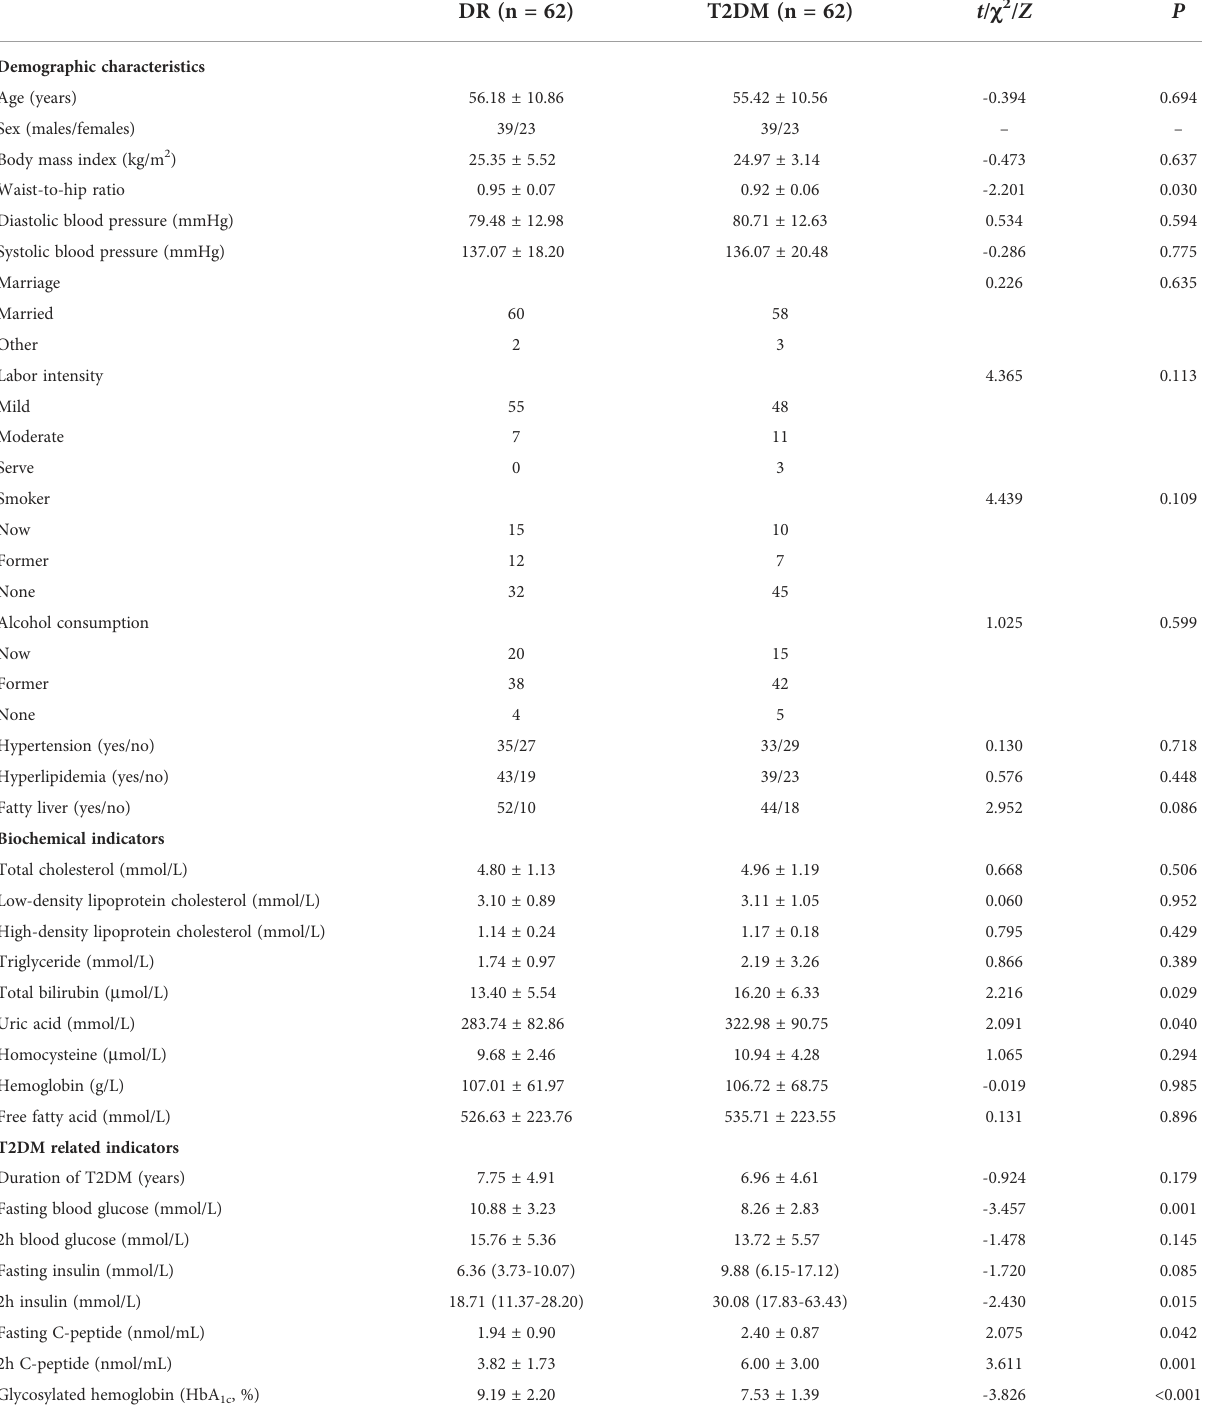
TABLE 1 Demographic and clinical characteristics of patients in DR and T2DM